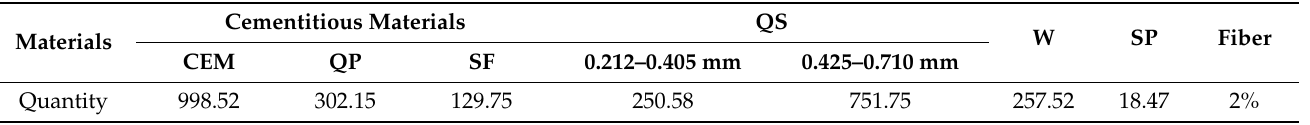
Table 1. Mix proportions of FRCM (kg/m 3 ).